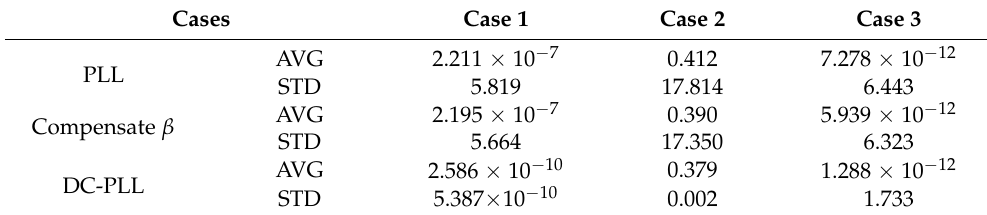
Table 2. The statistics of velocity estimation error ( (cid:101) ω ( ◦ / s ) ).